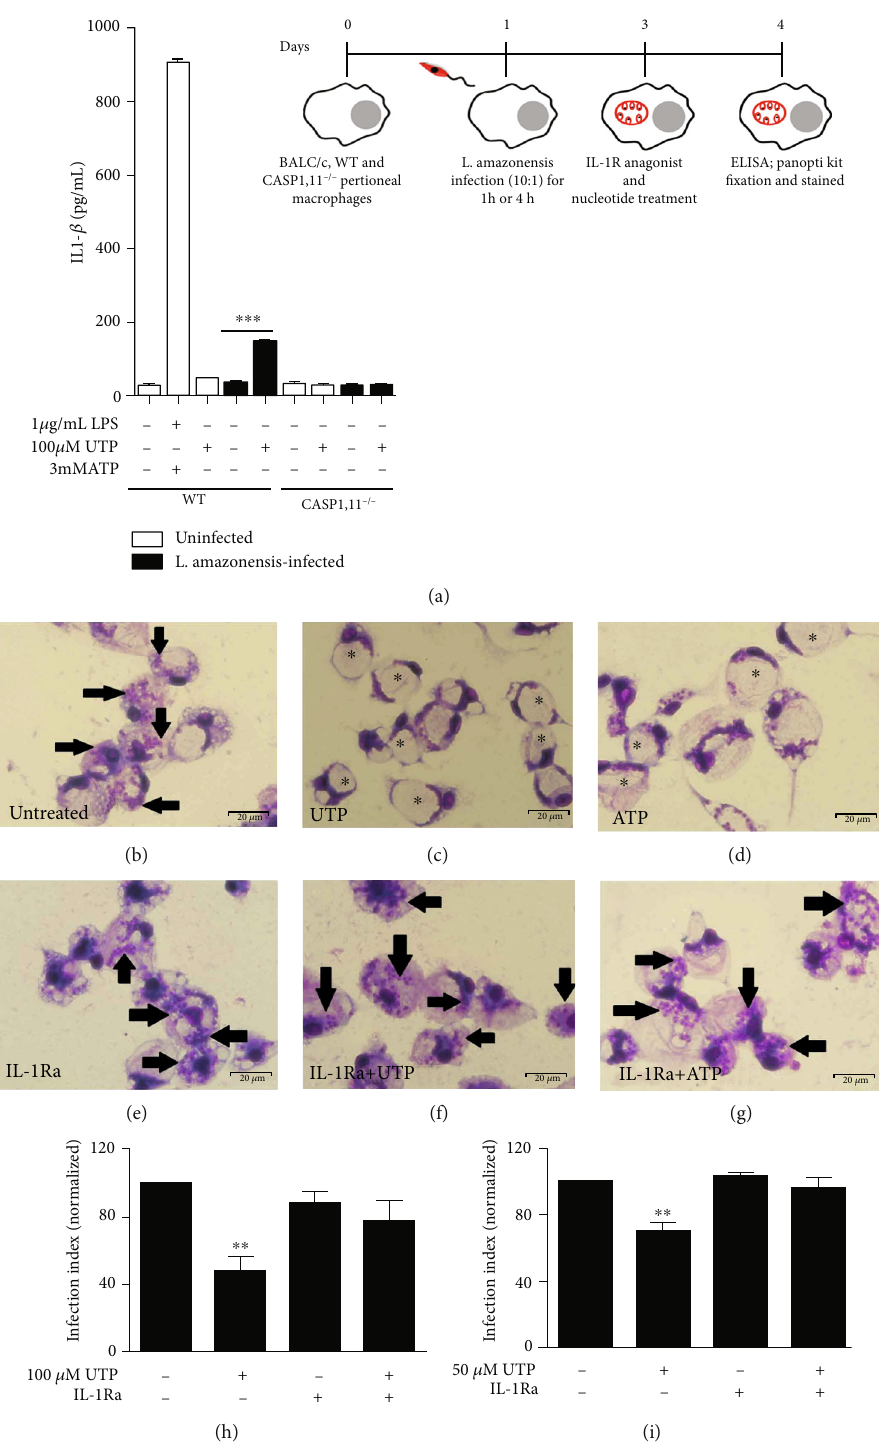
Figure 4: Control of L. amazonensis infection by UTP and ATP involves IL-1R signaling. (a) Peritoneal macrophages from WT and CASP 1,11 -/- mice were infected with L. amazonensis promastigotes for 1h and treated with UTP for 30min. Cell culture supernatants were harvested 4h later. Uninfected cells were primed with LPS (1 μ g/mL) for 2h followed by ATP (3 mM), as the second signal (a positive control). IL-1 β was measured 6h later in the positive control group. (b – d) BALB/c-infected macrophages untreated (e – g) or treated with IL-1Ra (100ng/mL) for 30 min prior (c, f) UTP and (d, g) ATP pulse for 30min. Twenty-four hours after nucleotide treatment, cells were fi xed and stained using the panoptic kit to measure parasitic load using the “ infection index ” (h, i). Data are mean ± SEM of three independent experiments performed in triplicate, with pools of 3 – 4 animals in each experiment. ∗∗∗ P < 0 : 0001 and ∗∗ P < 0 : 005 relative to the untreated group (one-way analysis of variance followed by Tukey ’ s